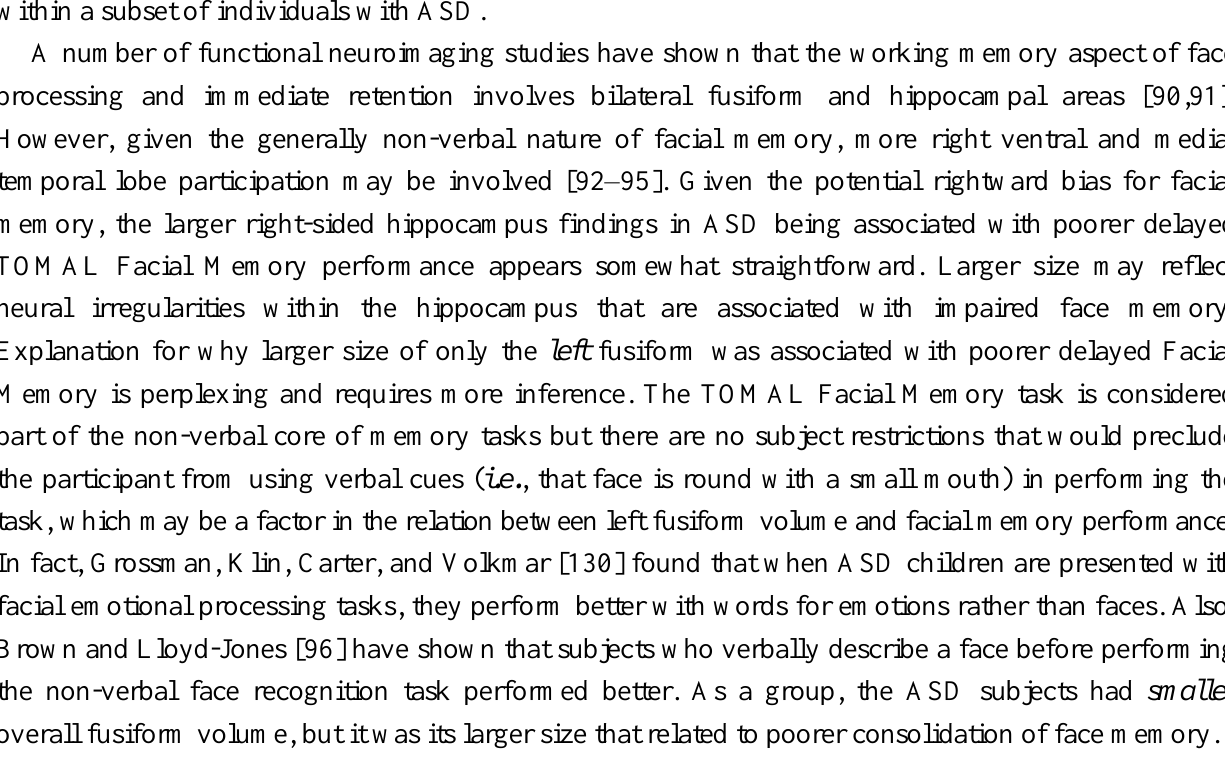
Figure 1. Relationship between Fusiform Gyrus Volume and Delayed Facial Memory Performance in ASD.